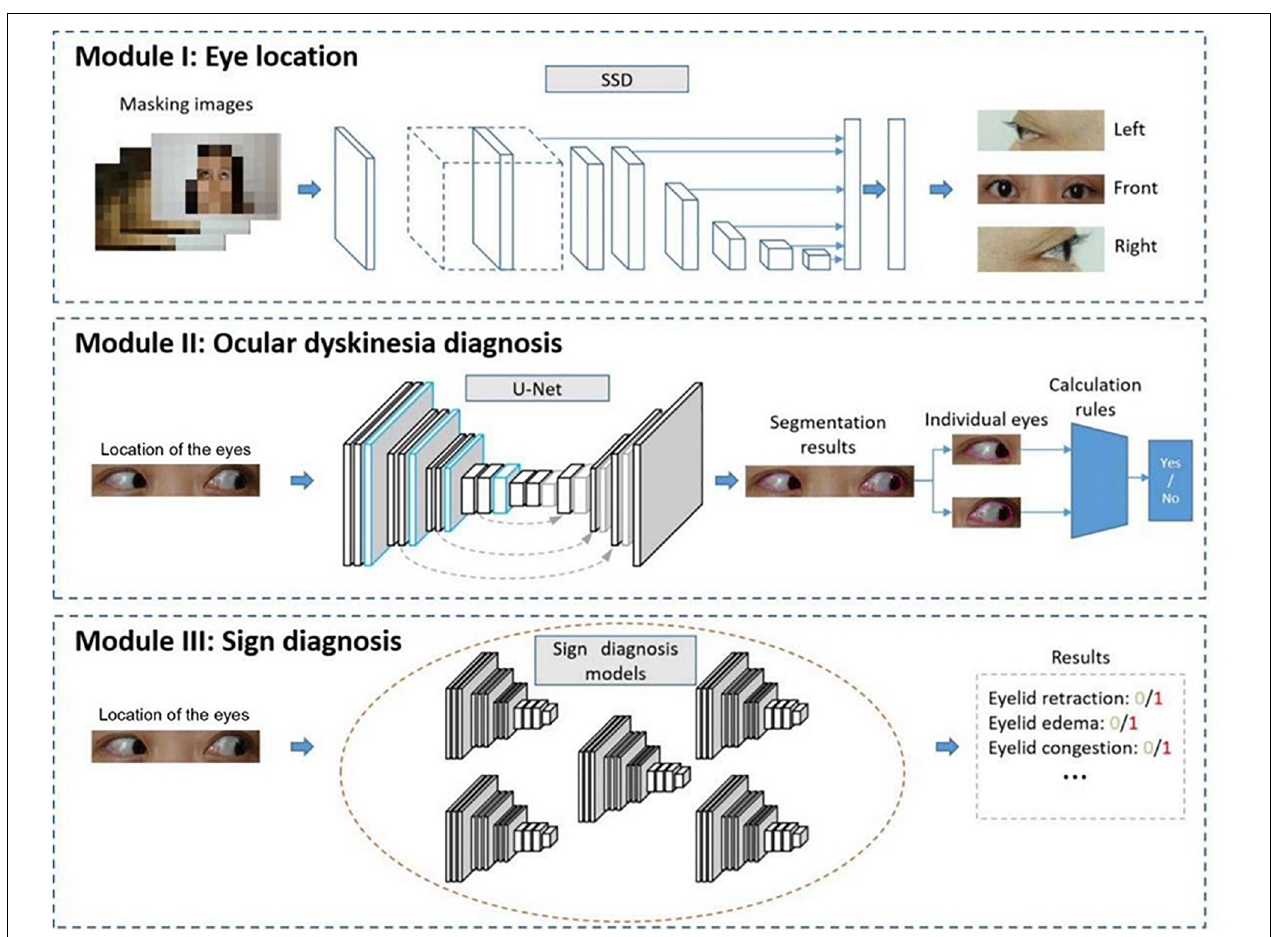
FIGURE 2 | Automated diagnostic system framework. The system framework includes Module I to detect the location of the eyes, Module II to diagnose ocular dyskinesia, and Module III to detect signs of thyroid-associated ophthalmopathy.